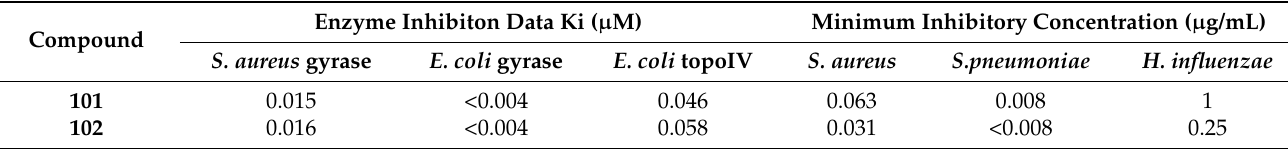
Table 12. Gyrase and Topoisomerase IV Inhibition and antibacterial activities of the compounds. Enzyme Inhibiton Data Ki ( µ Compound